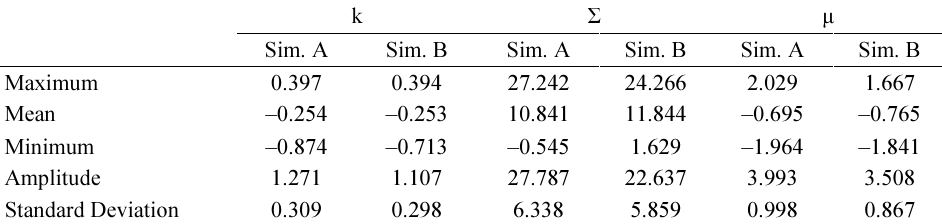
Table 5. Statistic analysis of the generalized Pareto distribution parameters